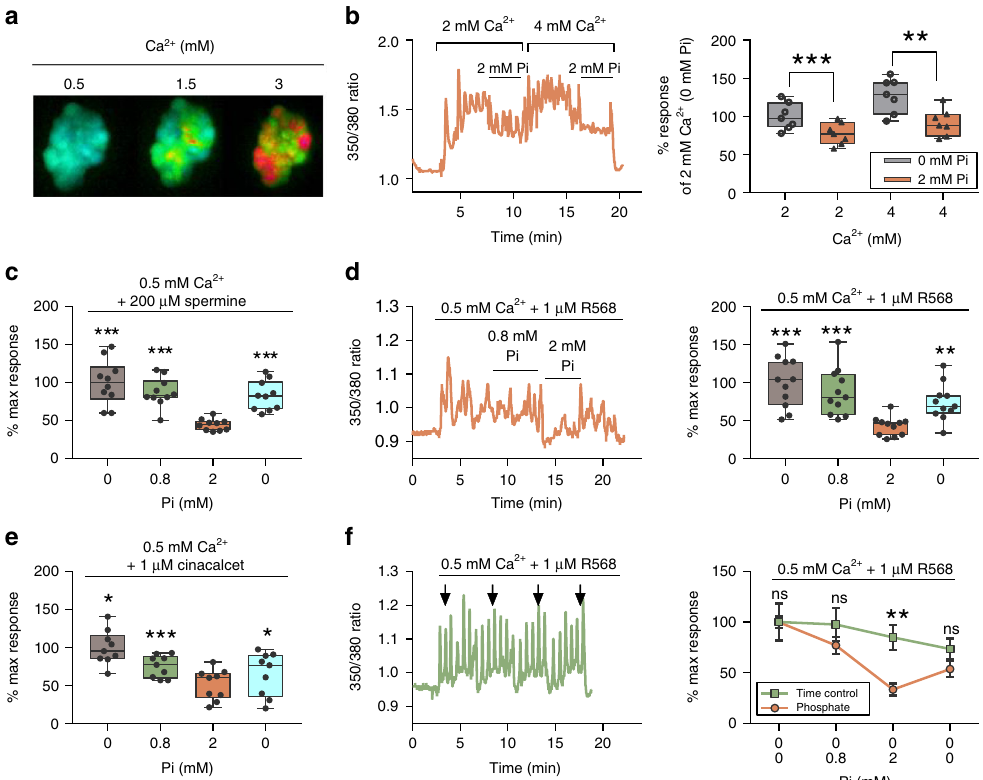
Fig. 1 Pathophysiologic concentrations of Pi signi fi cantly inhibit the CaSR. a Representative false-color images from epi fl uorescence imaging of Fura2- loaded CaSR-HEK cells showing CaSR-mediated Ca 2 þ i mobilization upon stimulation with increasing Ca 2 þ o concentrations (as indicated with warm colors). b – f Inhibitory effect of Pi on CaSR-mediated Ca 2 þ i mobilization upon stimulation with different concentrations of Ca 2 + ( b ), and cotreatment with R568 ( d, f ), spermine ( c ), and cinacalcet ( e ). b , d , f (left) Representative Ca 2 þ i mobilization traces (Fura2 ratio) from a single cell in response to Pi ( b , d ), and time-matched buffer changes without Pi ( f ). f Inhibitory effect of Pi on CaSR-mediated Ca 2 þ i mobilization upon stimulation with R568 compared with time- matched control in the absence of Pi; data shown as %mean ± SEM. Data expressed as percent control of the area under the curve for each treatment, n = 7 ( b ), n = 10 ( c ), n = 11 ( d ), n = 9 ( e ), and n = 9 ( f ). Data shown in box-and-whisker plots: box ends indicate upper and lower quartiles; midline indicates the median while error bars indicate the range. Data were analyzed by using RM-ANOVA with Dunnett ’ s multiple comparison ( b – e ) or unpaired t test ( f ). ns not signi fi cant; * P < 0.05, ** P < 0.01, and *** P < 0.001. Source data are provided as a Source Data fi